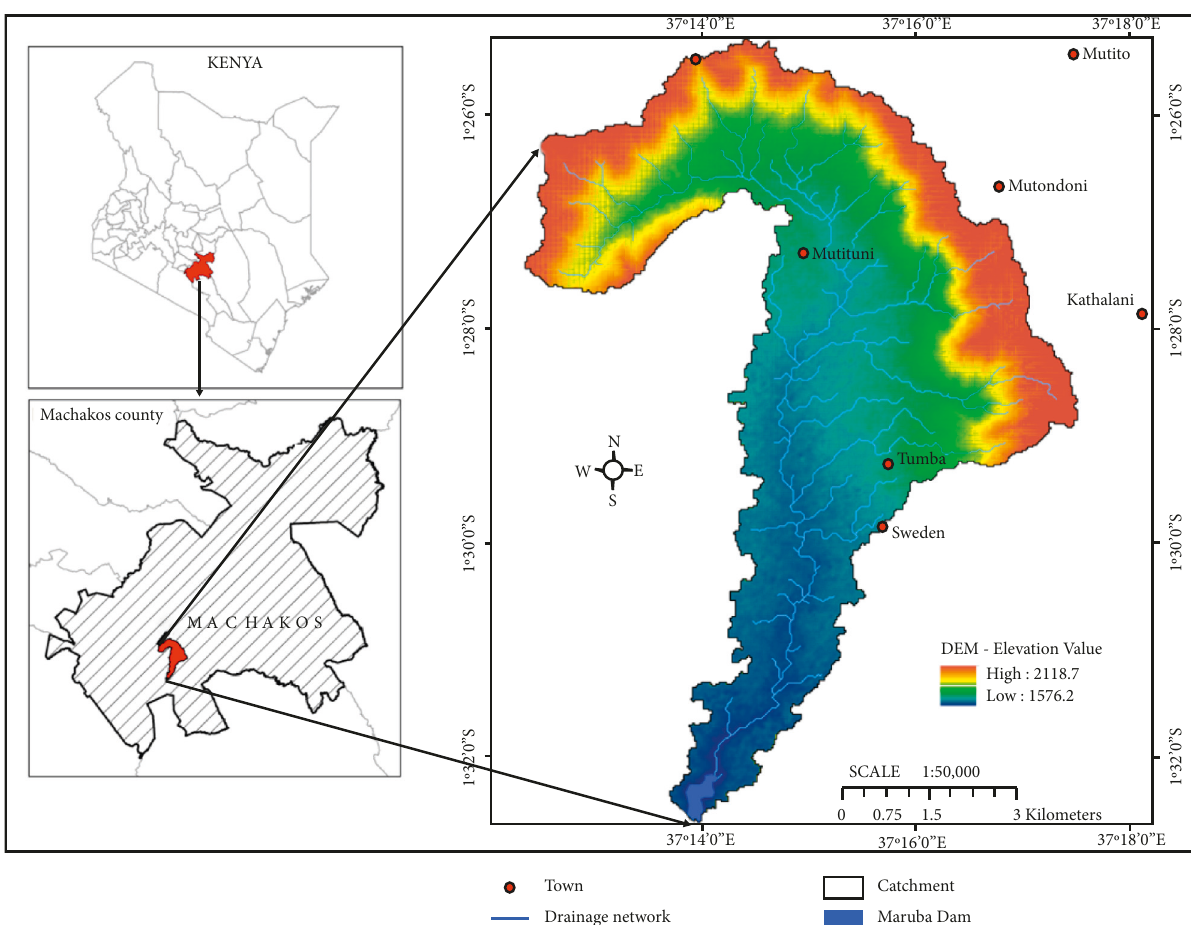
Figure 1: Location map for the study